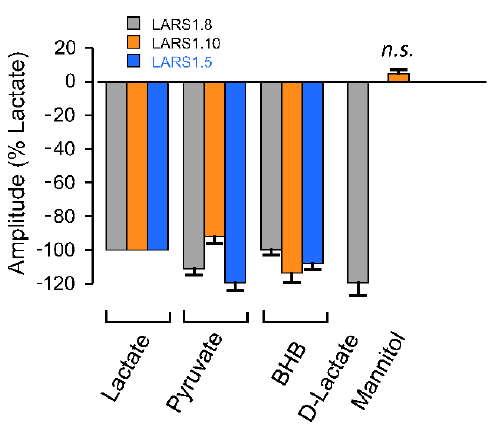
Figure 6. Selectivity candidate biosensor responses. The amplitude of responses of LARS1.8 ( n = 16 cell groups), LARS1.10 ( n = 14–17 cell groups) and LARS1.5 ( n = 3 cell groups) to pyruvate (10 mM), and β-hydroxybutyrate (10 mM). Additionally, D-lactate (10 mM), sensitivity and lack of sensitivity to mannitol (10 mM) were observed. Responses were normalized to the response to lactate (10 mM) on the same